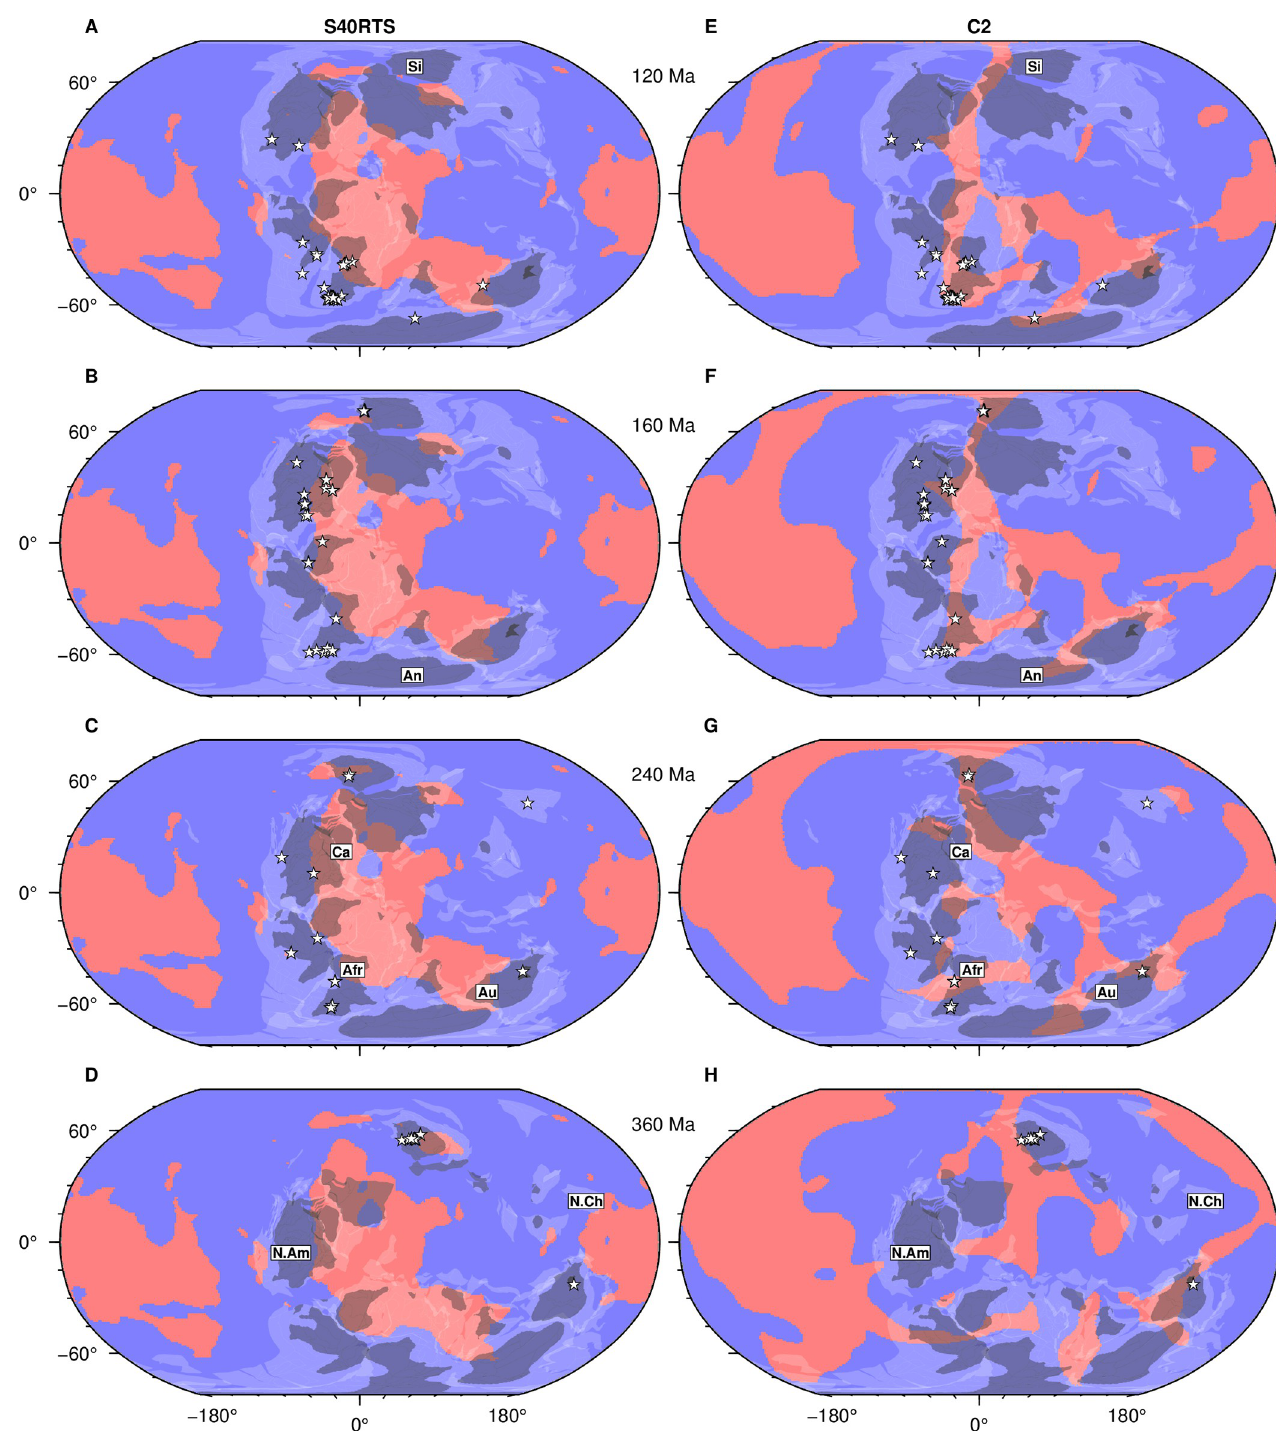
Fig 7. Evolution of the location of slow/hot basal mantle structures and kimberlite eruptions. Kimberlite eruption locations (stars) sampled in 20 Myr increments from ref. [22] continent outlines from ref. [38] (white transparent polygons) and lithosphere thicker than 150 km derived from ref. [5] (dark grey transparent polygons), all reconstructed at 120 Ma ( A, E ), 160 Ma ( B, F ), 240 Ma ( C, G ) and 360 Ma ( D, H ) with reconstruction M21NNR. The background shows cluster maps with basal mantle structures in pink for tomographic model S40RTS ( A-D ) and for mantle flow model Case 2 ( E-H ). The intersections of white and pink areas are high-potential regions for kimberlites. Labels: A / “Si”: Siberia; B / “An”: Antarctica; C / “Afr”: Africa, “Au”: Australia, “Ca”: Canada; D / “N.Am”: North America. This figure was created with GMT6 [47] and the Global Self-consistent, Hierarchical, High-resolution Geography Database (GSHHG) coastlines are republished from [48] under a CC BY license, with permission from Paul Wessel, original copyright 1996. https://doi.org/10.1371/journal.pone.0268066.g007 PLOS ONE | https://doi.org/10.1371/journal.pone.0268066 June 9,